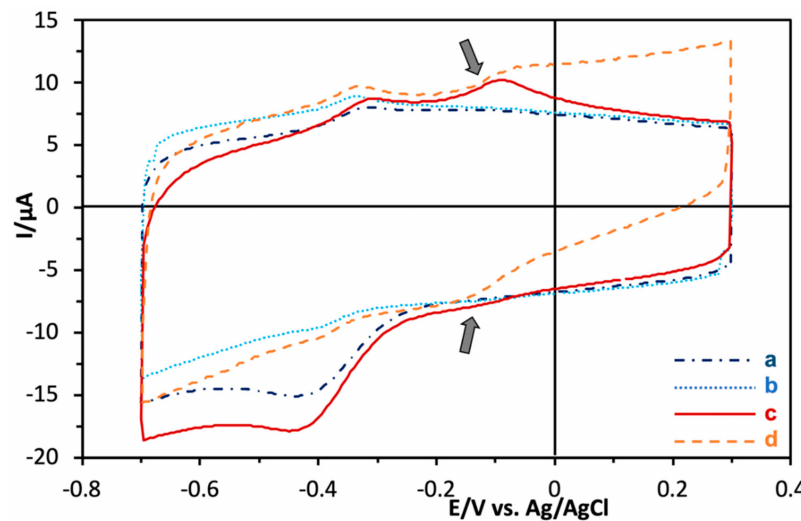
Figure 2. Cyclic voltammograms of ( a ) unmodified An GOx-I489K in the absence of glucose. ( b ) Unmodified An GOx-I489K in the presence of 33 mM glucose. ( c ) PES-modified An GOx-I489K in the absence of glucose. ( d ) PES-modified An GOx-I489K in the presence of 33 mM glucose. Scan rate 50 mV / s. Arrows: peaks due to